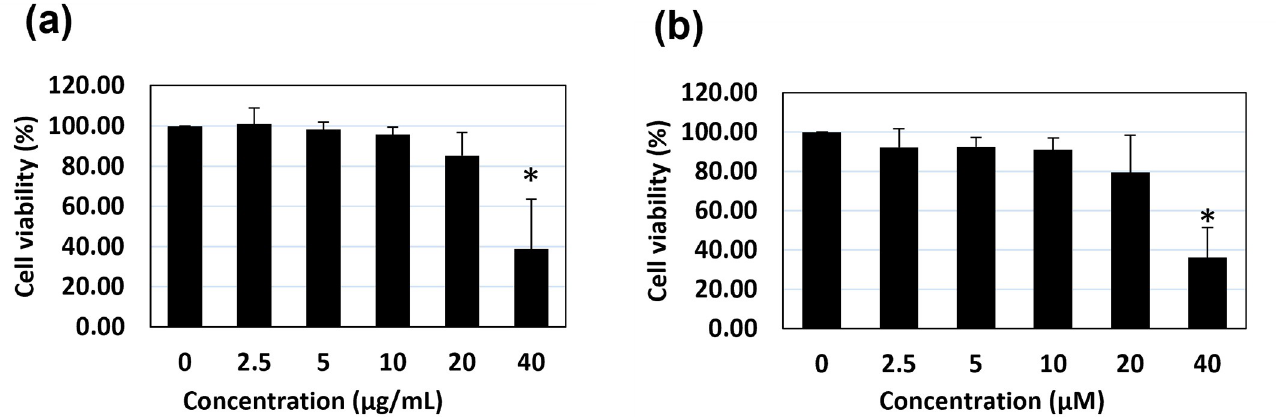
Fig 2. Cytotoxicity assay of AM and AC on DPCs. DPCs were treated with various concentrations of (a) AM (0–40 μ g/mL) and (b) AC (0–40 μ M) for 48 h. Cell viability was evaluated by PrestoBlue 1 assay. The data is presented as mean + SD (n = 3). * p < 0.05 versus non-treated cells. https://doi.org/10.1371/journal.pone.0284853.g002 concentrations of 10 μ g/mL AM and 10 μ M AC for cell cycle analysis and further experiments. DPCs were treated with AM (10 μ g/mL) and AC (10 μ M) for 48 h, followed by an analysis of their cell phase distribution by a flow cytometer. The results showed that both the AM extract and the AC significantly decreased the number of cells in the G0 phase, and simultaneously increased those in the G2-phase (as compared to the control; Fig 3). On the other hand, no sig- nificant differences were observed between the treated and the non-treated cells in terms of the cell population numbers undergoing their G1 and S phases. Since the G0 cells represent apoptotic cells and the G2 phase represents the active phases of DNA synthesis and cell